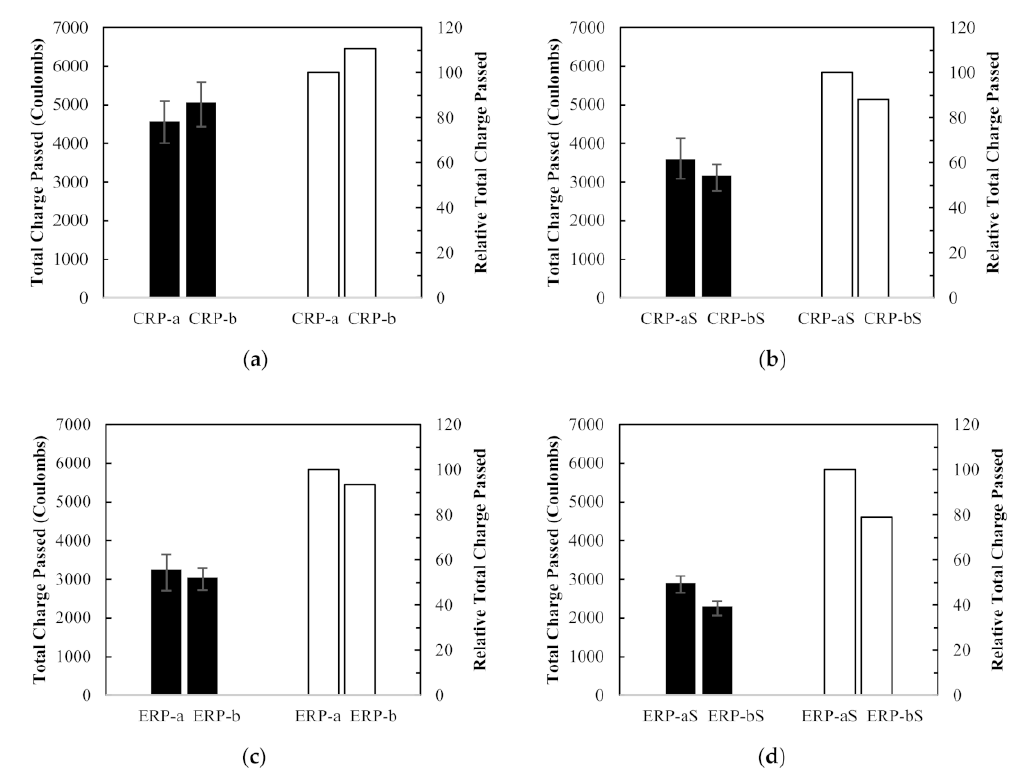
Figure 15. Rapid Chloride Penetration Test results and relative values between different recycled concrete aggregate replacement ratios: ( a ) CRP-a, ( b ) CRP-b, ( c ) ERP-a, and ( d ) ERP-b.